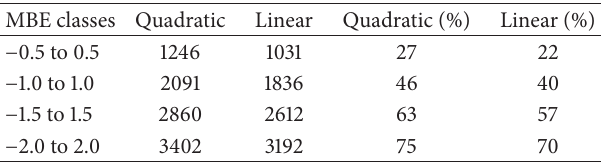
Table 3: Total number of days with MBE within a specified range and corresponding total percentages for the whole study period. MBE classes Quadratic Linear Quadratic (%) Linear (%) − 0.5 to 0.5 1246 1031 27 22 − 1.0 to 1.0 2091 1836 46 40 − 1.5 to 1.5 2860 2612 63 57 − 2.0 to 2.0 3402